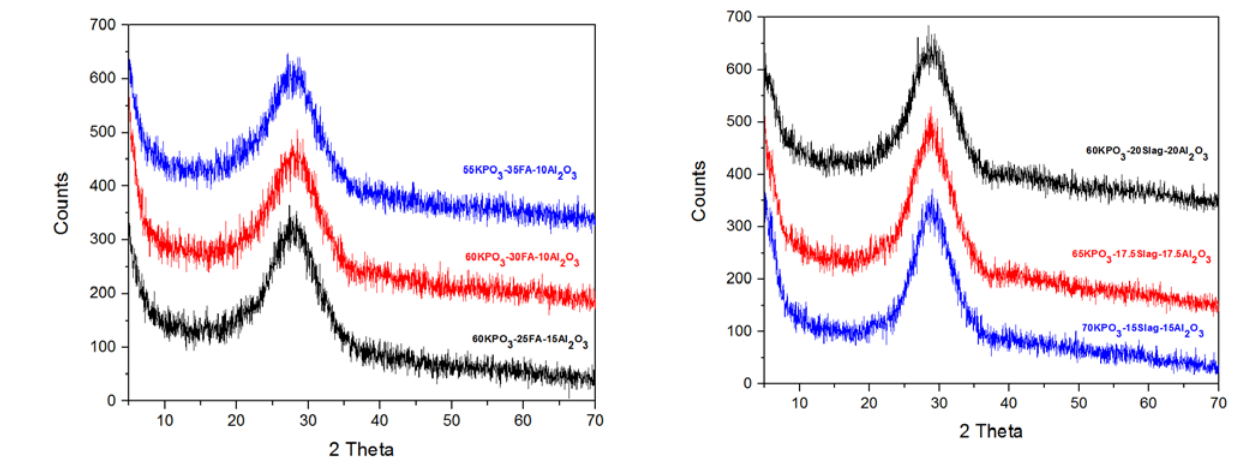
Fig. 8 X-ray pattern of the samples with high concentration of fly ash. Fig. 9 X-ray pattern of the samples with high concentration of